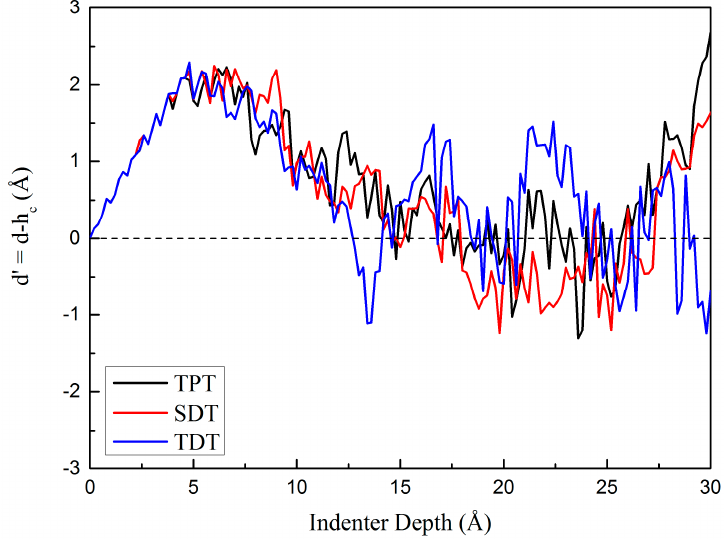
Figure 5. Curves of d’ with the indenter depth of three different models.